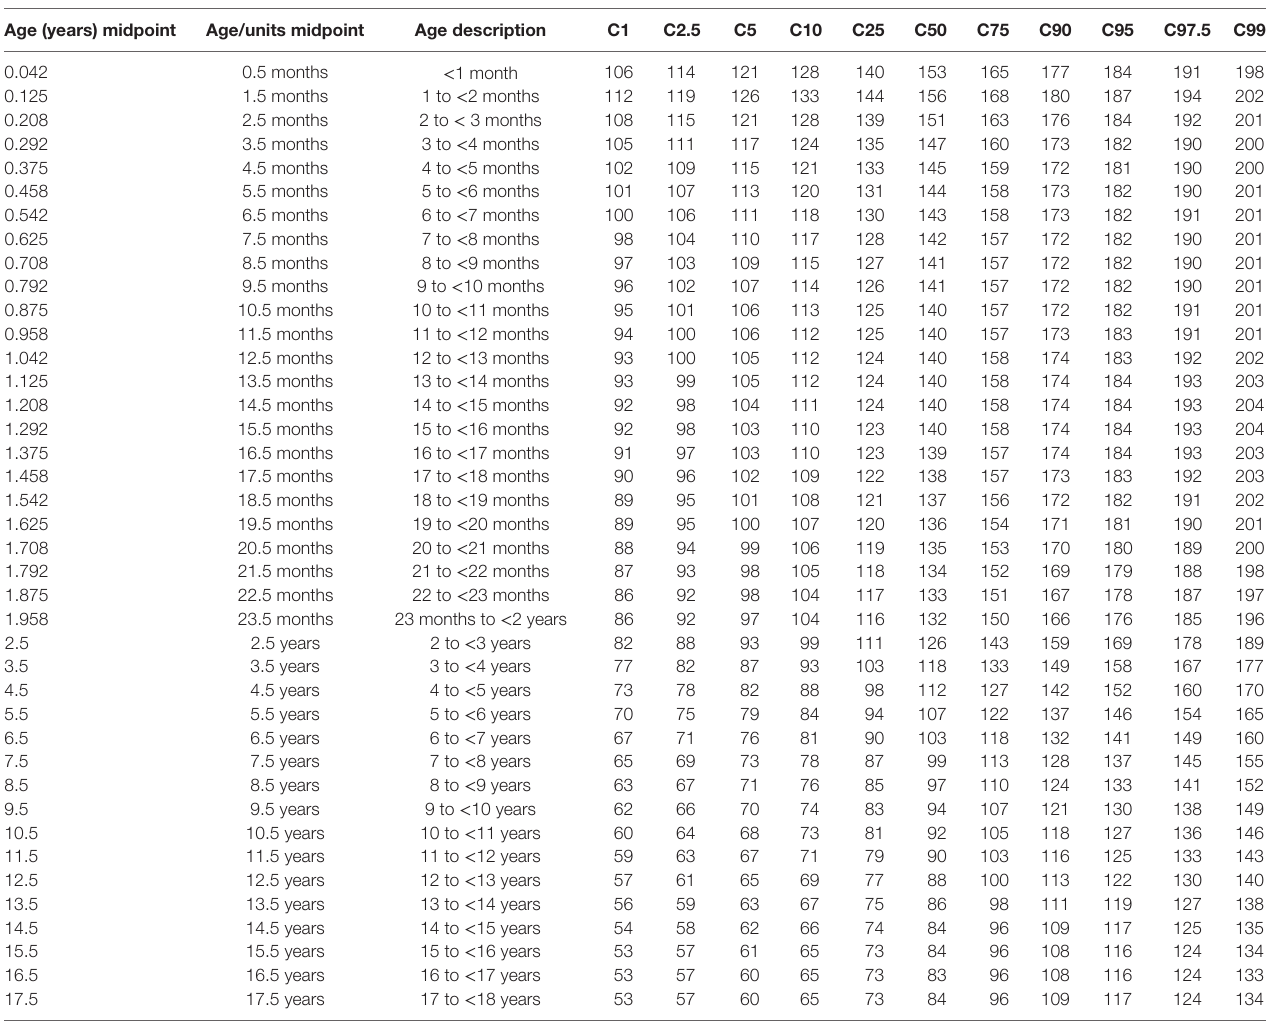
TaBle 4 | Heart rate (HR, bpm) centiles a by